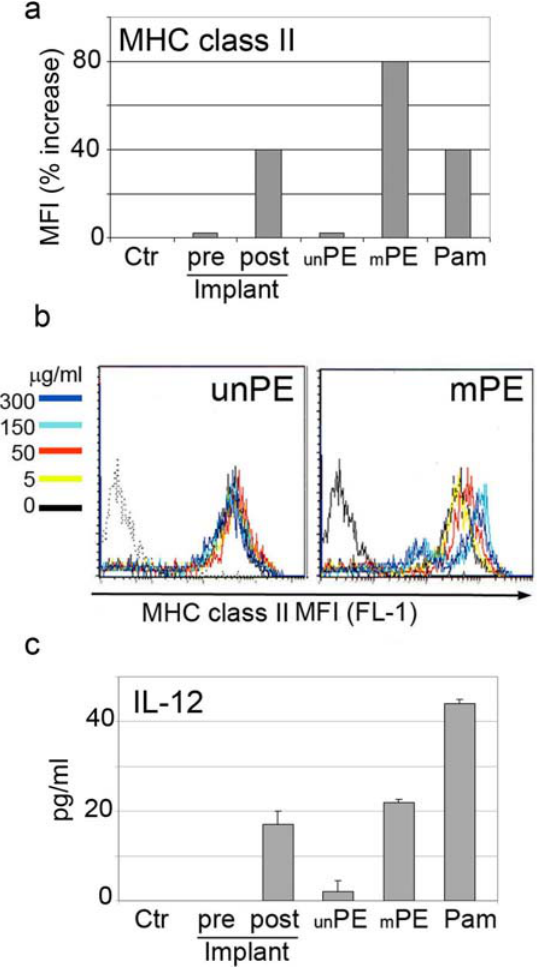
Figure 4. Modified alkane polymers induce DC activation and IL- 12 secretion. a) FACS analysis of DC untreated or treated for 48 hours with unPE, mPE, pre and post implant alkane polymers. Surface staining was performed with antibodies to MHC class II molecules, Data are shown as increase in MFI as compared to the untreated control. b) Histograms overlay of MHC class II staining in DC untreated or treated with different concentrations of unPE and mPE. c) Elisa for IL-12 present in the supernatant of DC untreated or treated for 48 hours with unPE, mPE, pre and post implant alkane polymers (data are expressed in pg/ml).